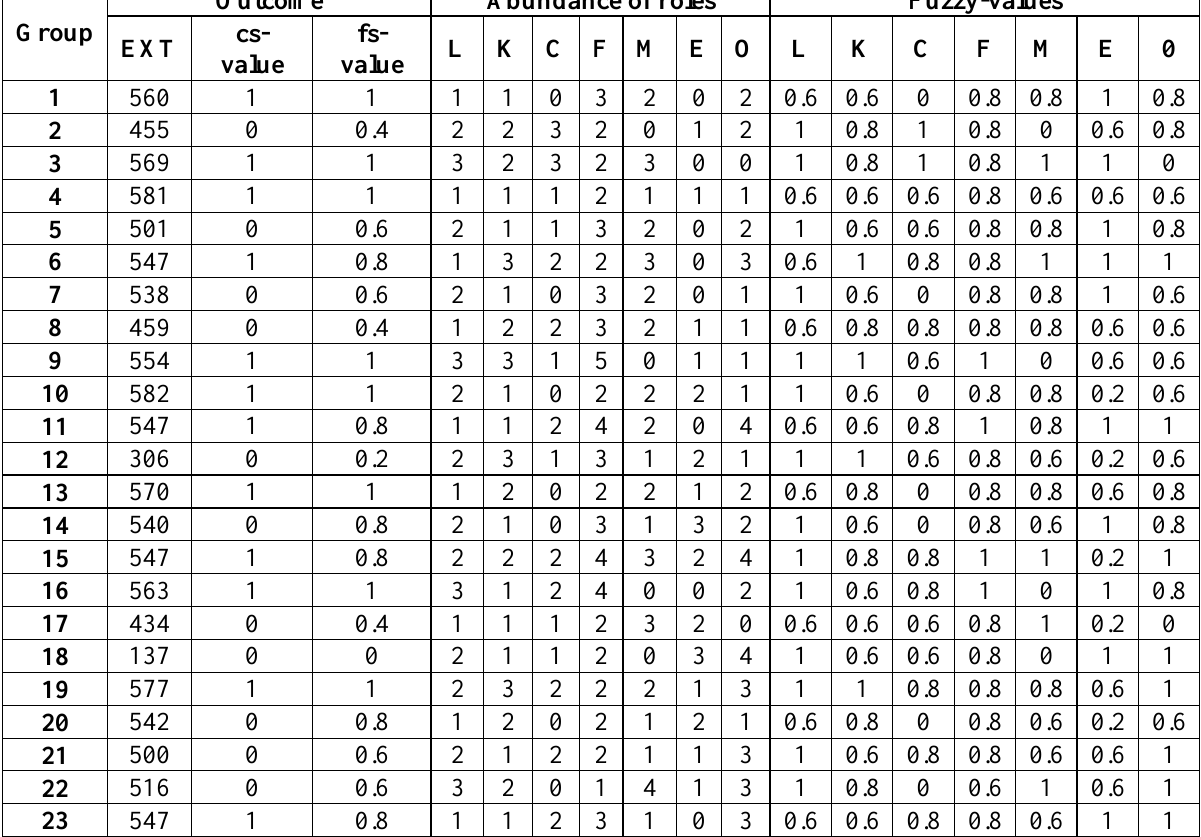
Table A3.1. Crisp- and fuzzy-values of all conditions and the outcome group extraction (EXT). Conditions are the social roles: L=Leader, K=Knowledge generator, C=Connector, F=Follower, M=Moralist, E=Enforcer,